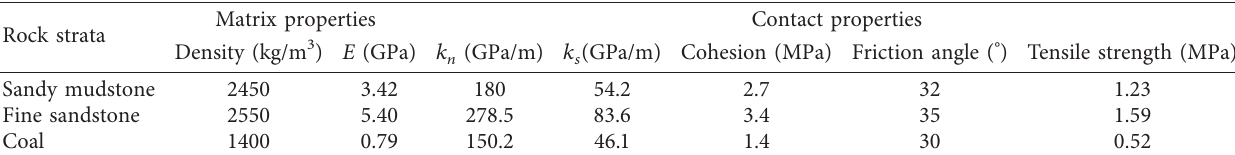
Table 2: Calibration of mechanical properties of rock strata and coal seams used in the model. Matrix properties Contact properties Rock strata